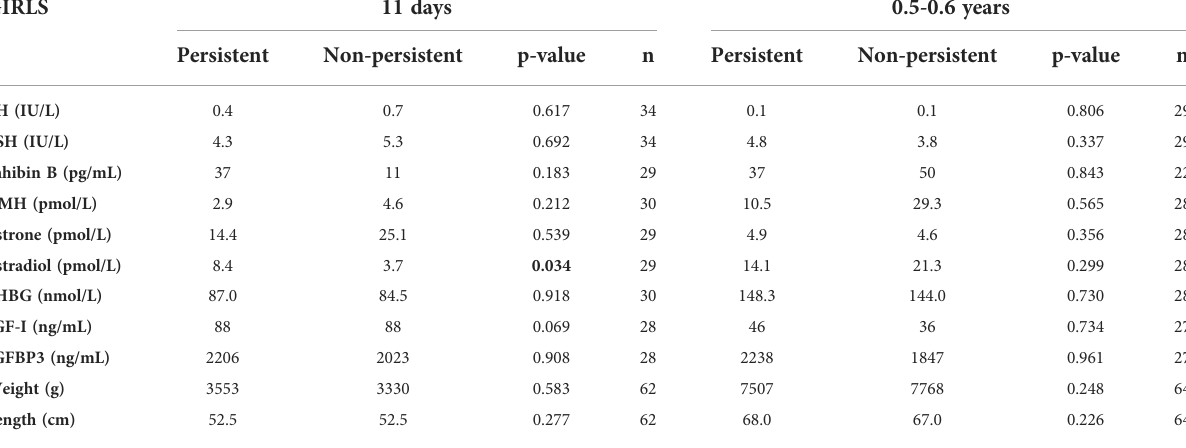
TABLE 2 Median hormone concentrations and anthropometric measures and total counts (n) in girls with persistent and non-persistent breast tissue in infancy at the initial exam (median age 11 days) and at the exam between 0.5-0.6 years of age.